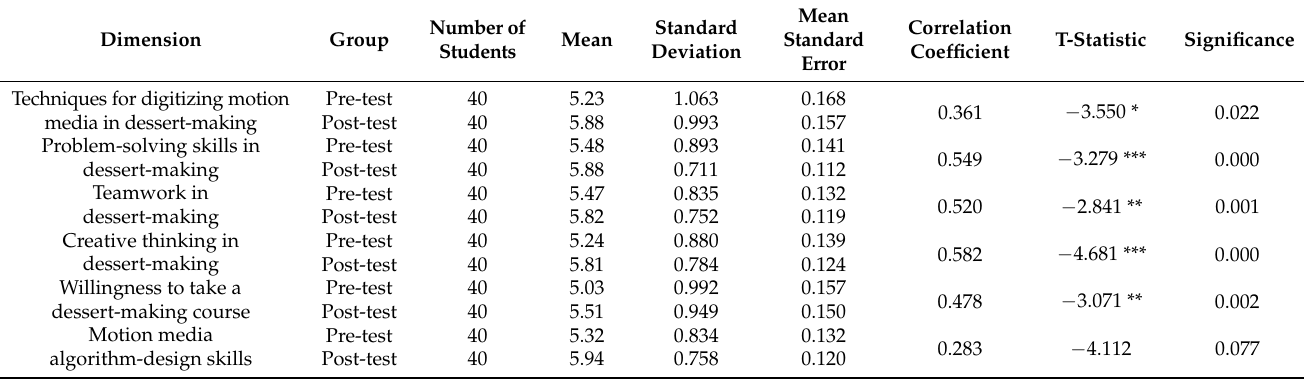
Table 3. Paired sample t -test results of students’ pre-test learning